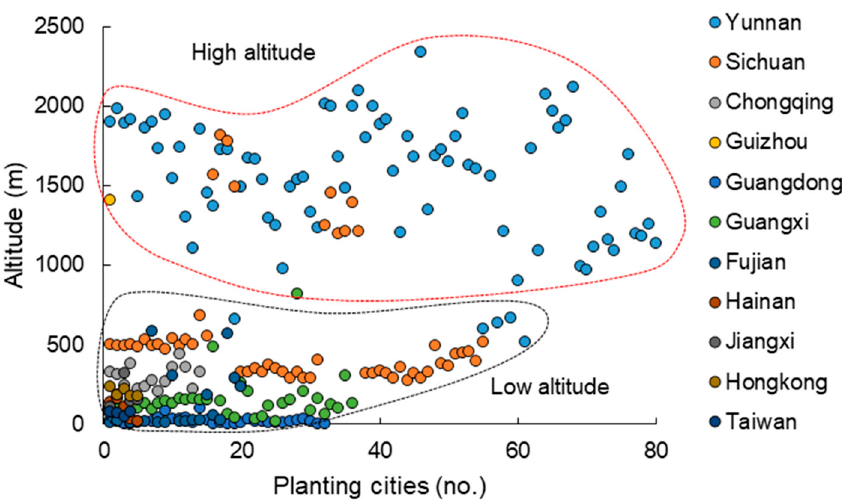
Figure 3. Vertical distribution pattern of the planting cities of J. mimosifolia grouped by 11 provinces in China. Using 800 m as the dividing line for cultivation areas of J. mimosifolia at different altitudes, the distribution can be classified into low-altitude and high-altitude zones.